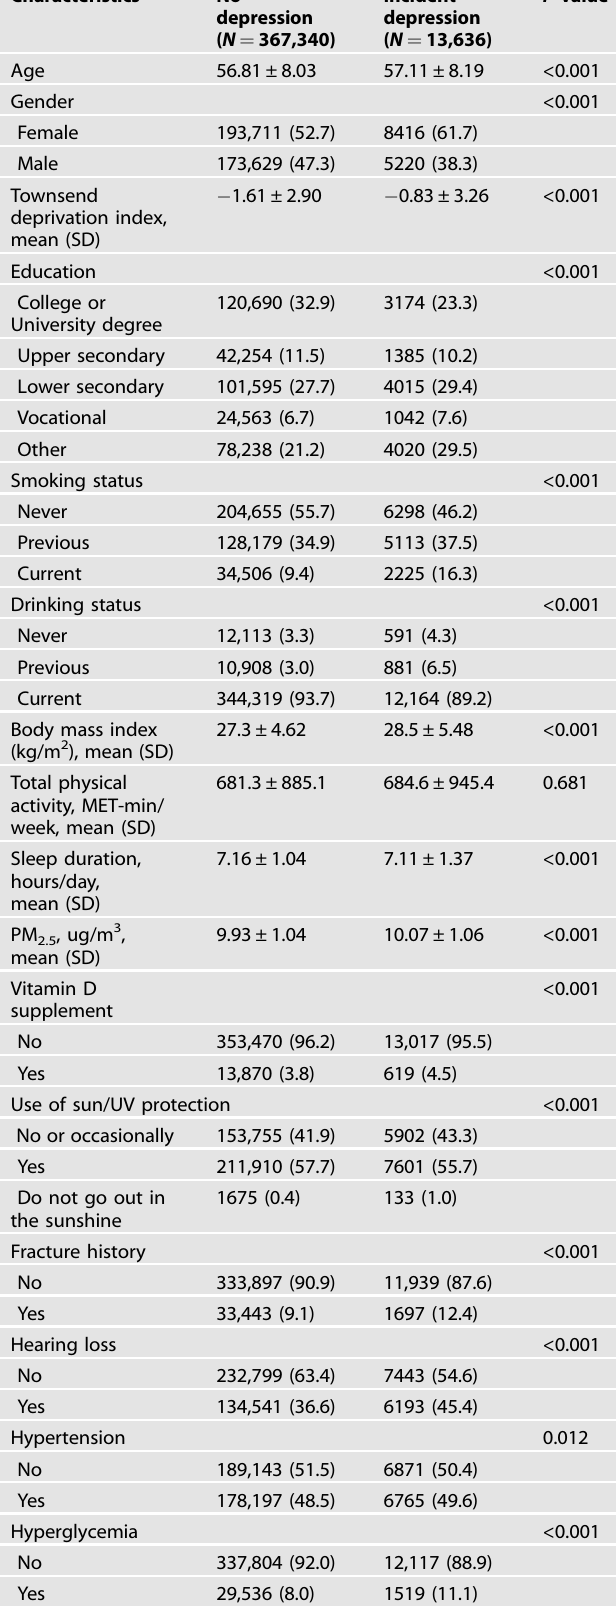
Table 1. Baseline characteristics of